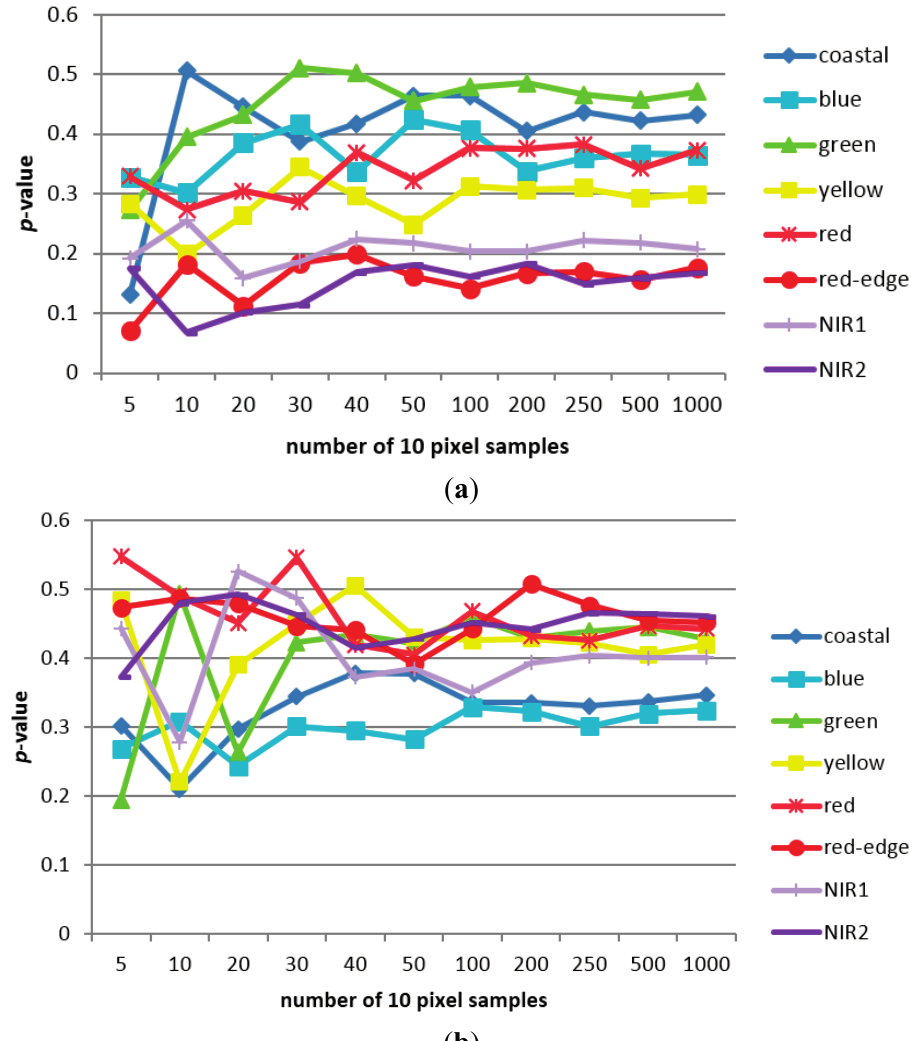
Figure 8. The per-band p -value computation between segments with similar land covers (two black roofs) when different numbers of 10 pixel samples were applied and